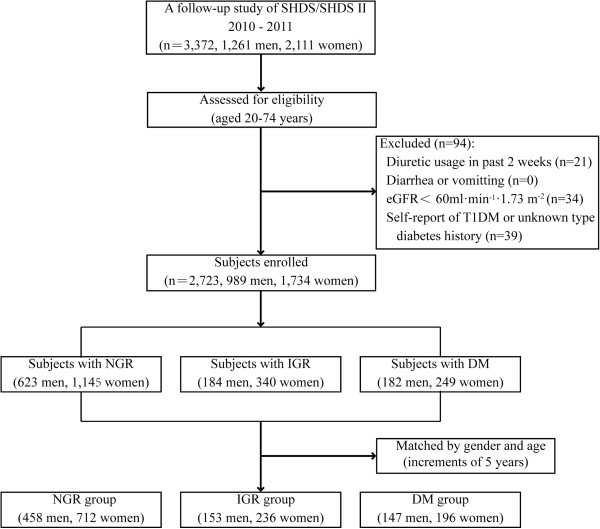
Flow diagram of subject recruitment.